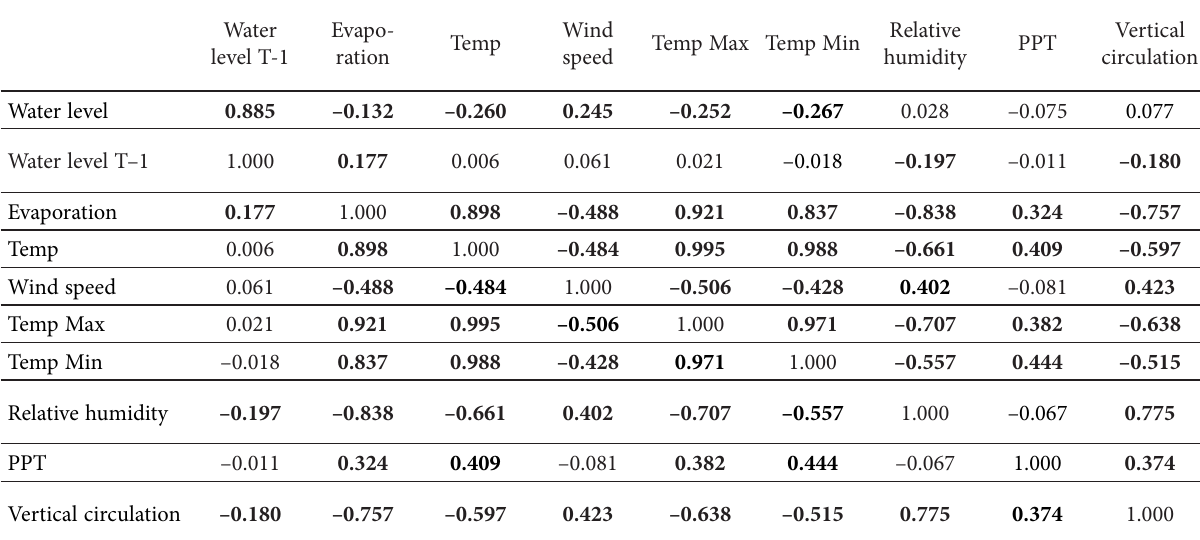
Table 2. Coefficient of correlation matrix for one-month-lagged exogenous variables, bold font indicated correlation coefficients which exhibit statistical significance – P value <0.05. PPT stands for precipitation, whereas Temp for temperature